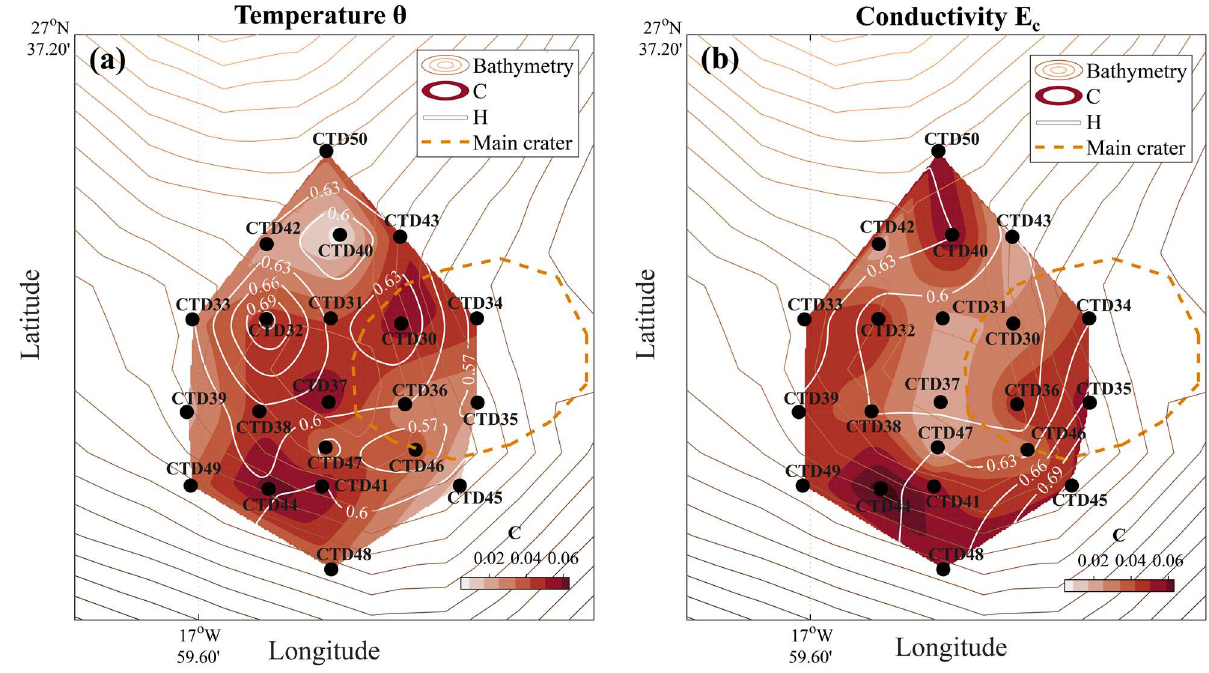
Figure 7. High-resolution grid distribution of ( a ) temperature, θ , and ( b ) conductivity, E c , measurements above of the main crater. The black dots indicate the position where the CTD time series were registered over the seafloor. The filled contours represent the C parameter, while the white contours show the values of the Hurst parameter. The main crater (dashed orange line) is located over the CTDs 30, 34, 35, and 36.